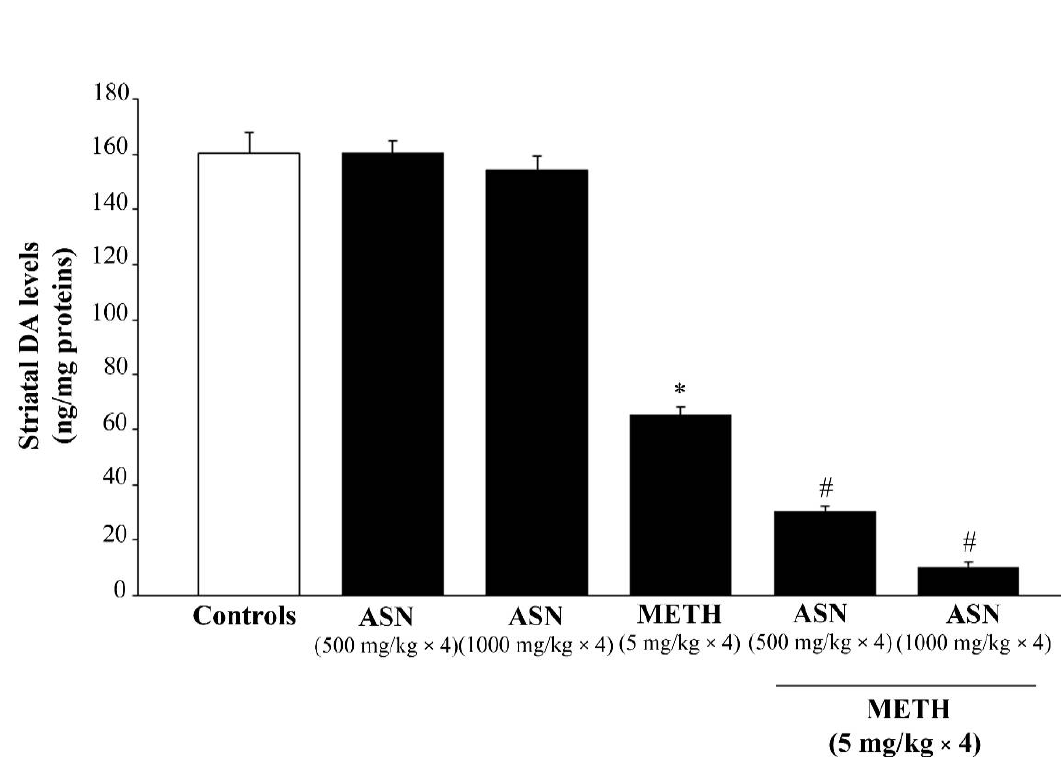
Figure 3. ASN administration dose-dependently exacerbates METH-induced striatal DA loss. Graph reports DA levels mea- sured by reversed phase HPLC coulometric detection of striatal homogenates following ASN and/or METH administration. * p < 0.05 compared with Controls; # p < 0.05 compared with